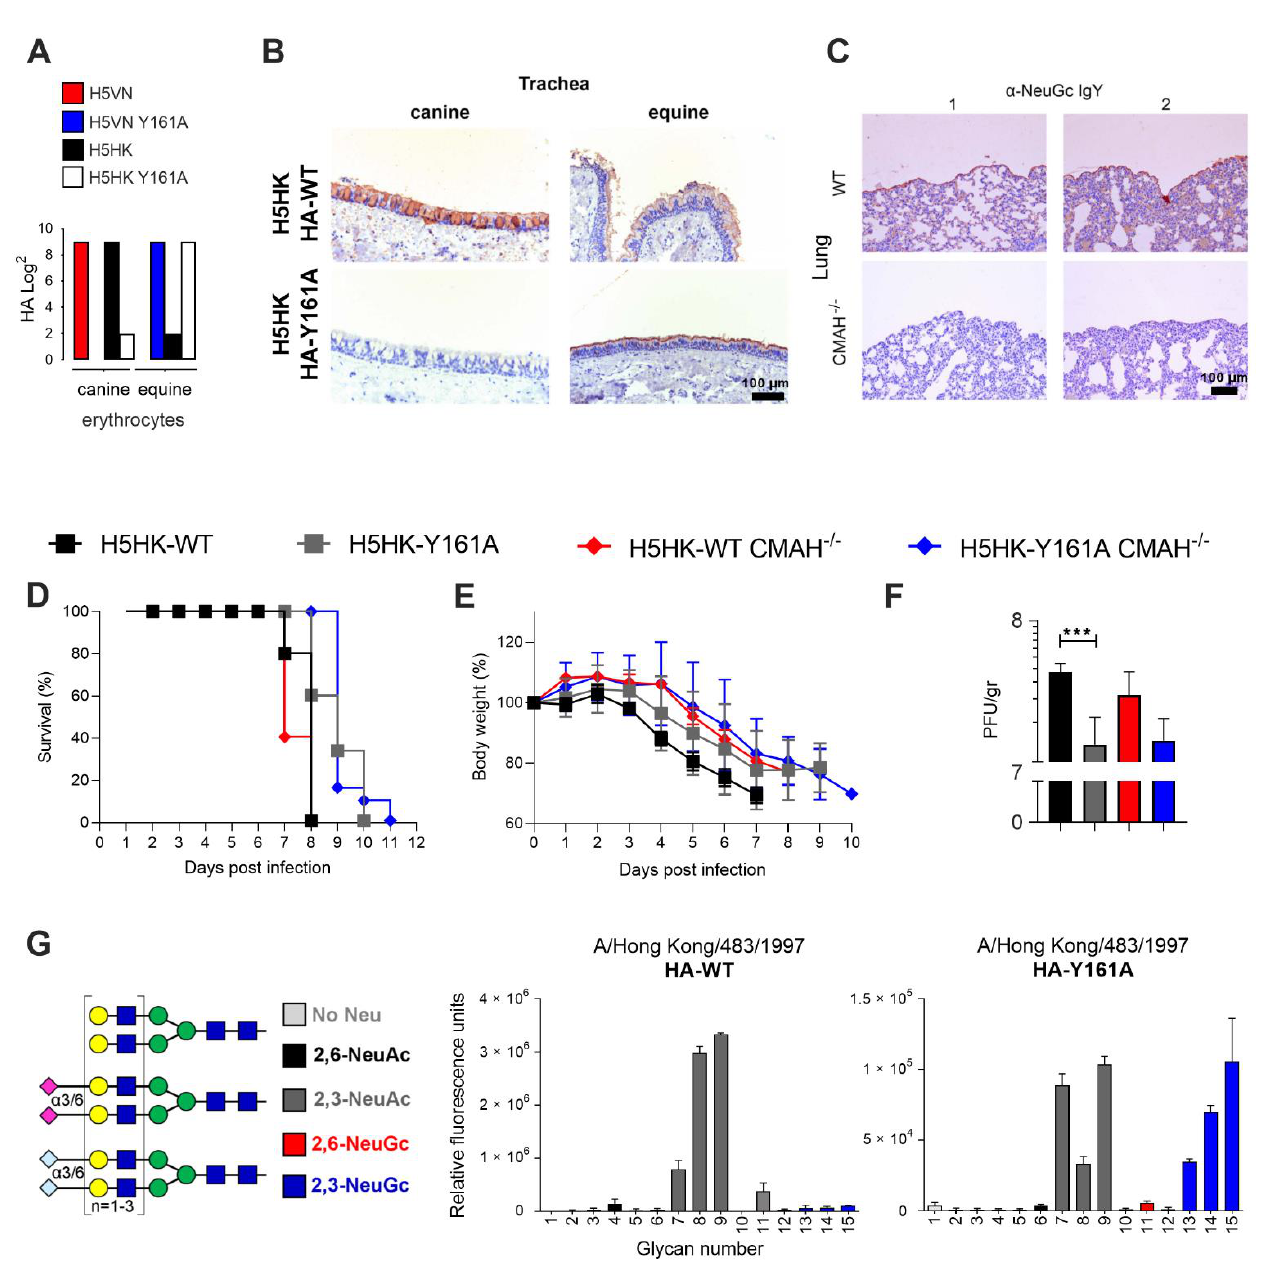
Figure 3. H5 WT and HA-Y161A binding properties and infectivity in WT (C57BL/6) and CMAH −/− mice. ( A ) A hemag- glutination assay ( n = 3) with canine and equine erythrocytes was performed using HAs of WT and Y161A mutants of—A/Vietnam/1203/2004 (H5VN) and A/Hong Kong/483/1997 (H5HK). ( B ) Tissue binding of the HA of H5HK WT and mutant Y161A on canine and equine trachea is visualized with AEC staining (representative for three independent assays), the scale bar represents 100 µm. ( C ) Mice lungs (WT and CMAH −/− knockout) were stained in duplicate with anti-Neu5Gc IgY and binding was visualized with AEC staining. WT (C57BL/6) and CMAH −/− knockout mice ( n = 5) were infected with H5HK WT and HA-Y161A mutant virus and ( D ) the survival and ( E ) body weight curves are shown, together with the ( F ) PFU per gram at 3 dpi in the lungs ( n = 5), *** indicates a p -value of 0.0007 in an unpaired two-tailed t-test. ( G ) Synthetic glycans printed on the microarray ( n = 6), either without sialic acid (structures 1–3, light gray), with α 2,6-linked Neu5Ac (4–6, black), α 2,3-linked Neu5Ac (7–9, dark gray), α 2,6-linked Neu5Gc (10–12, red) or α 2,3-linked Neu5Gc (13–15, blue). Binding specifities of WT and Y161A mutant H5HK HAs were investigated.